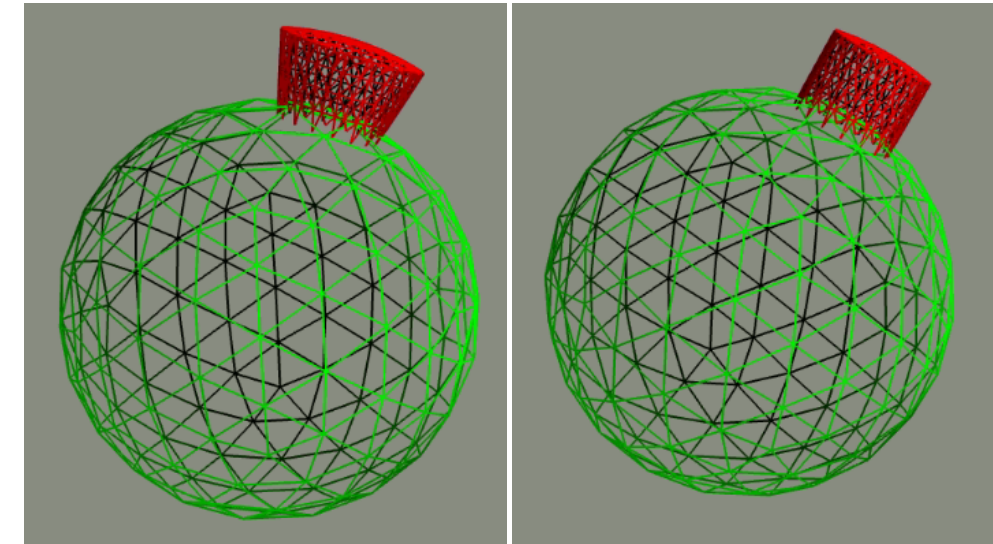
Figure 1. Two columns shapes, cone trunk shape in the left, and a cylindrical shape in the